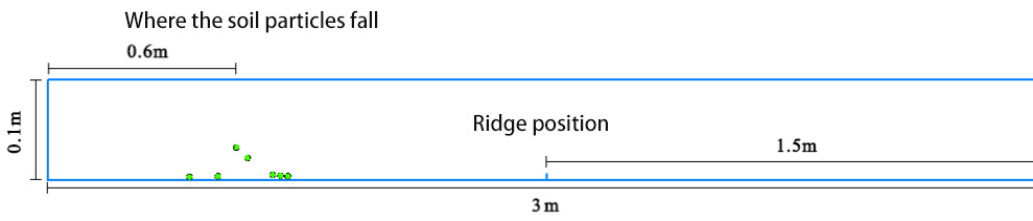
Figure 5. A drainage pipe model (unit: m).